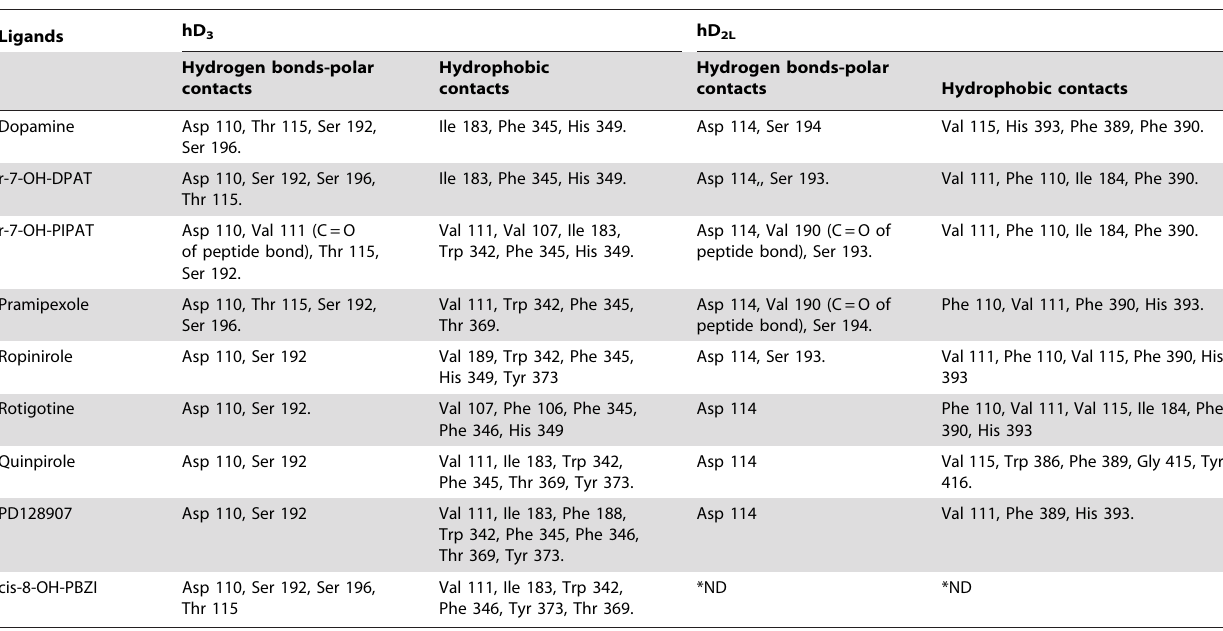
Table 3. Ligand protein-interaction of D 3 –preferring receptor agonists docked with AD4.2.